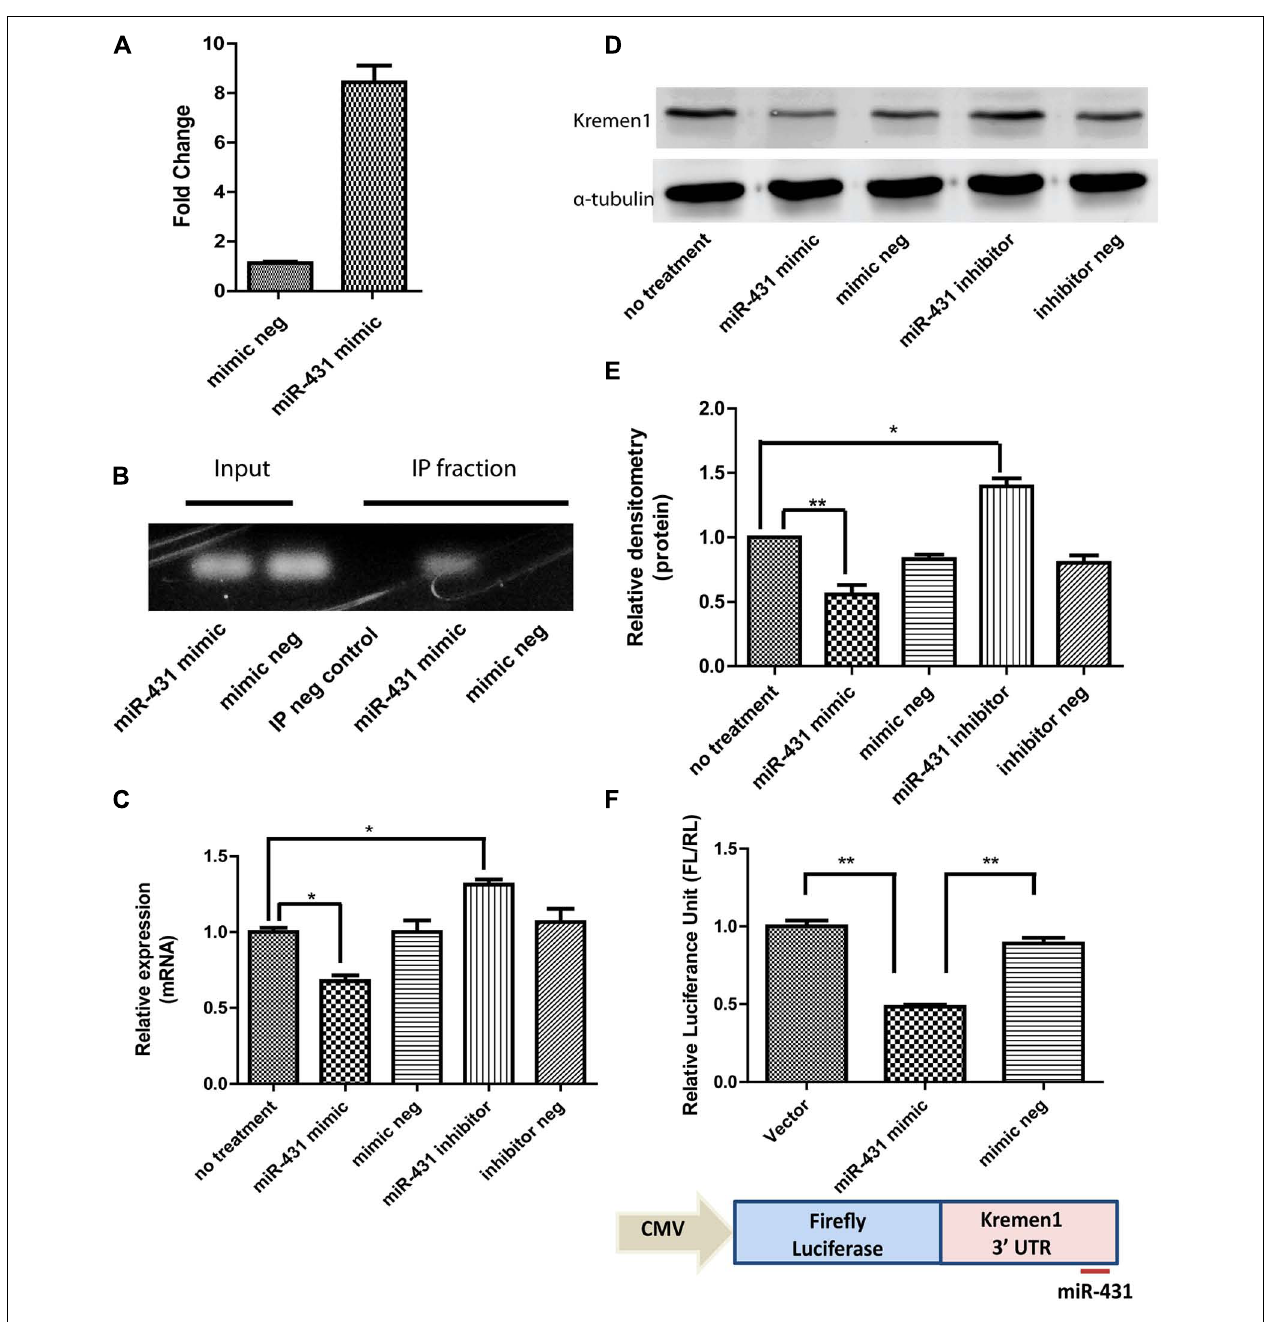
Western blot analysis of Kremen1 expression exhibited similar negative correlation of miR-431 and Kremen1 expression. Cells transfected with miR-431 mimics had decreased protein level of Kremen1 , whiles cells transfected with miR-431 inhibitors had an increased expression